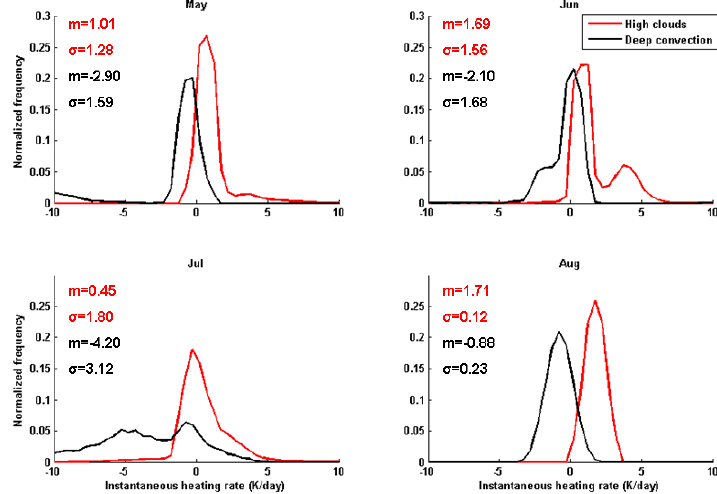
Figure 11. Probability density functions of instantaneous CRH for cloudy bins located above LZRH in all three regions (Z1–Z3) north of the equator for the years 2006–2010. The symbols m and σ denote mean and standard deviation respectively.